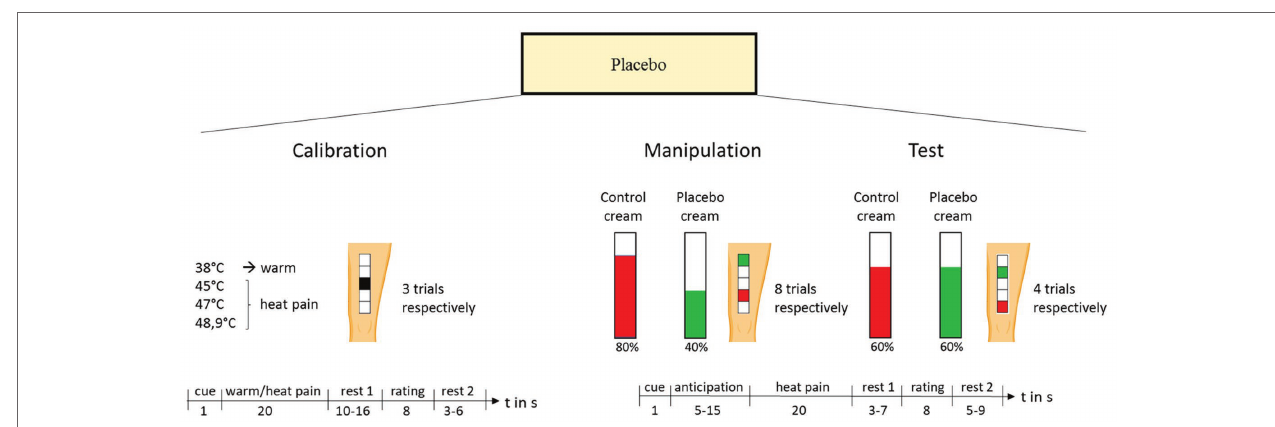
FIGURE 3 | Placebo paradigm. The placebo paradigm consisted of three phases: calibration, manipulation, and test. Before the experiment started, five 4 × 4 cm 2 squares were drawn on the participants’ left thigh to mark the stimulation sites. Subjects were informed that they would receive pain-inhibition cream/inactive control cream on the skin areas outlined in green/red. The two upper/lower squares were outlined in green/red and designated as the site for later placebo/control cream stimulation. The assignment of placebo cream or control cream to the upper/lower patches was randomized across subjects. During the calibration phase, the middle square was used to determine the individual temperatures to evoke pain levels of 40, 60, and 80 on the VAS, ranging from 0 = no pain to 100 = unbearable pain. Therefore, a pseudo-random sequence of 12 20-s thermal stimuli with different intensities (38, 45, 47, and 48.9 ° C, three trials, respectively) was applied while the participants were asked to rate the intensity of each stimulus on the presented VAS. The individual temperatures evoking VAS ratings of 40, 60, and 80 were calculated via linear regression of the calibration ratings. Before the manipulation phase started, participants were told that they would be stimulated with the same pain level on both skin patches (placebo cream and control cream). Unbeknown to them, they were stimulated with a pain level of VAS 80 to the control site and with a pain level of VAS 40 for stimuli applied to the placebo site. The conditioning phase consisted of a pseudo-random sequence of placebo cream/control cream stimulation with eight trials each. The test phase consisted of a pseudo-random sequence with four trials per stimulation site. Importantly, participants were stimulated with the same temperature (equivalent to 60 on the VAS) at both stimulation sites (placebo-control). This physically identical stimulation allowed for the assessment of the individual placebo analgesic effect (i.e., reduced pain ratings under placebo cream compared with control cream).